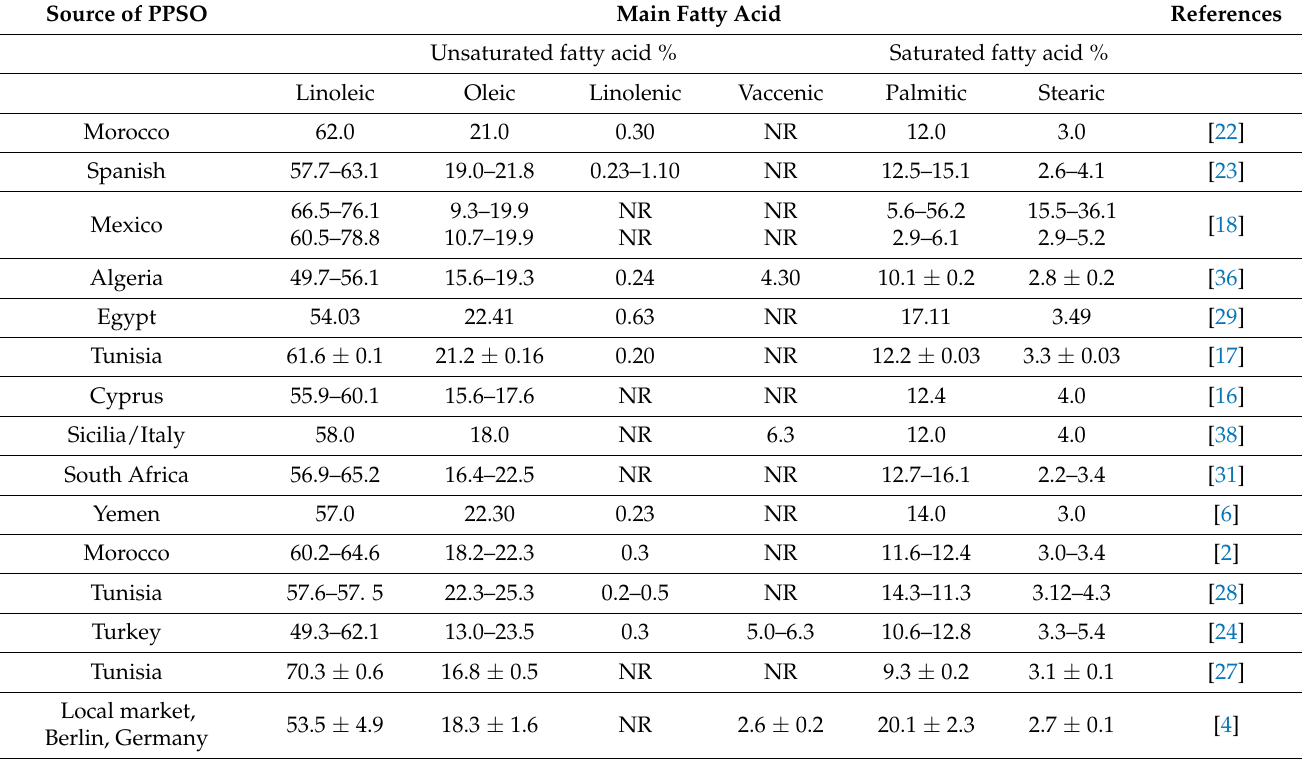
Table 3. Main fatty acid composition of prickly pear seed